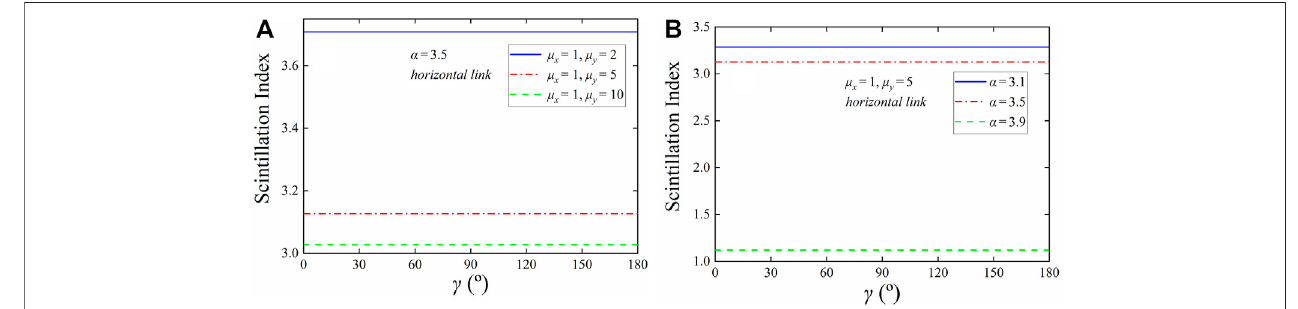
FIGURE 1 | Scintillation index of a plane wave versus the anisotropic tilt angle γ for the horizontal link. (A) With various anisotropic factor μ x and μ y values; (B) with various power law α